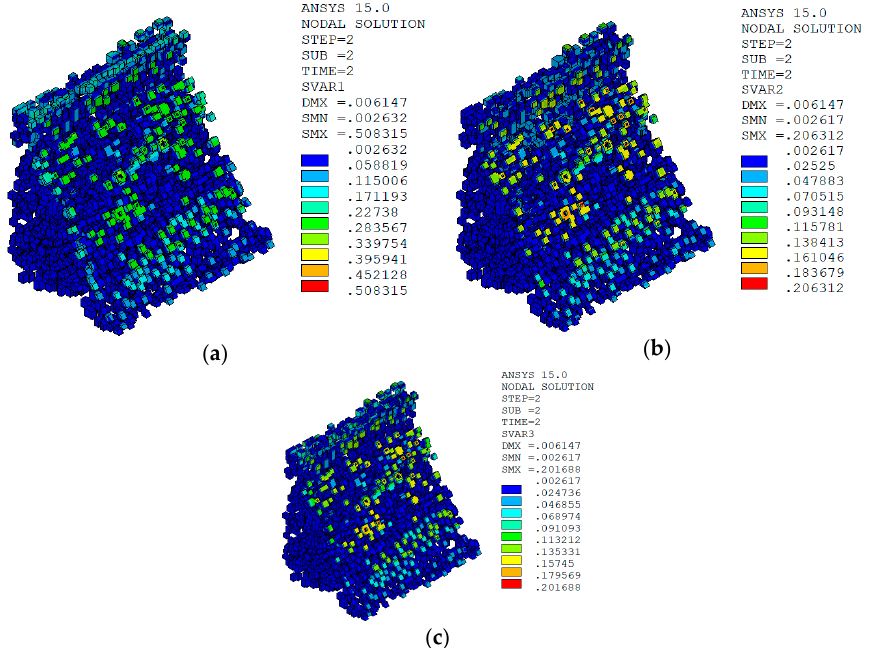
Figure 21. The temperature damage distribution of the ITZ material in the three principal strain directions is calculated by the macro-meso model under the temperature rise condition, ( a ) The temperature damage distribution in the first principal strain direction, ( b ) The temperature damage distribution in the second principal strain direction, ( c ) The temperature damage distribution in the third principal strain direction. The three principal strain cloud charts on the section z = 21 m along the dam axis are shown in Figure 22.